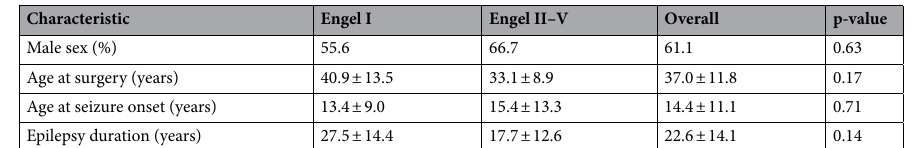
Table 1 shows the patient demographics. Eleven of 18 patients were men. The mean age at the time of sur- gery was 37.0 ± 11.5 (mean ± standard deviation) years, ranging from 21 to 63 years. The mean duration from the onset of the seizure disorder to surgery was 22.6 ± 13.7 years. A classical ATL was performed in six patients (33.3%), a SAH was performed in five patients (27.8%), and an ATL with MST was performed in three patients (16.7%). Extended ATL was performed in four patients (22.2%). After surgery, the mean follow-up duration was 71.3 ± 33.0 months. The outcome did not significantly vary by gender, age at the time of surgery, or duration of the onset of epilepsy disorder to the time of surgery (Table 2). Six patients had a history of encephalitis or meningitis. Five out of six patient outcomes were classified as residual. Surgical outcome. The determination of laterality by each modality is listed in Table 3. In each case, the information provided by each modality to determine the best side to resect, as well as the actual side resected, and the 2-year postoperative outcome are described. Nine patients (50%) achieved well-controlled seizure out- comes within Engel class I at a 2-year follow-up. There were no surgical complications. Analysis of data. Table 4 shows the concordance rate between the findings by each modality and the resected side where patients achieved well-controlled seizure outcomes. The determination of the best side for resection based on HV was significantly concordant with the actual resected side where patients achieved well- controlled seizure outcomes (p = 0.0498). No significant agreement was observed with the other preoperative evaluations.